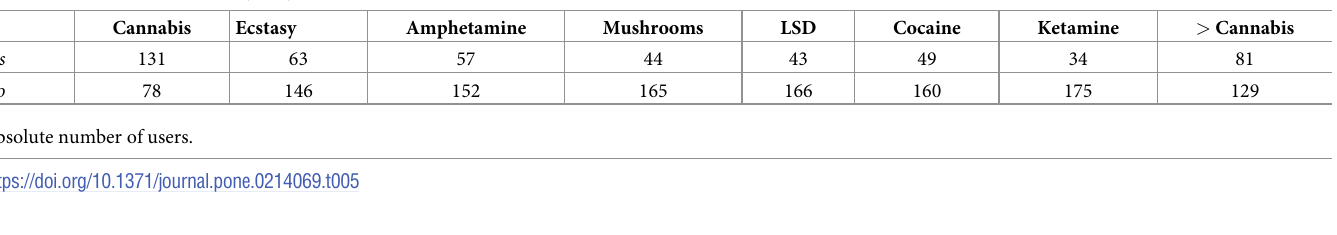
Table 5. Consumed substances (Ever).